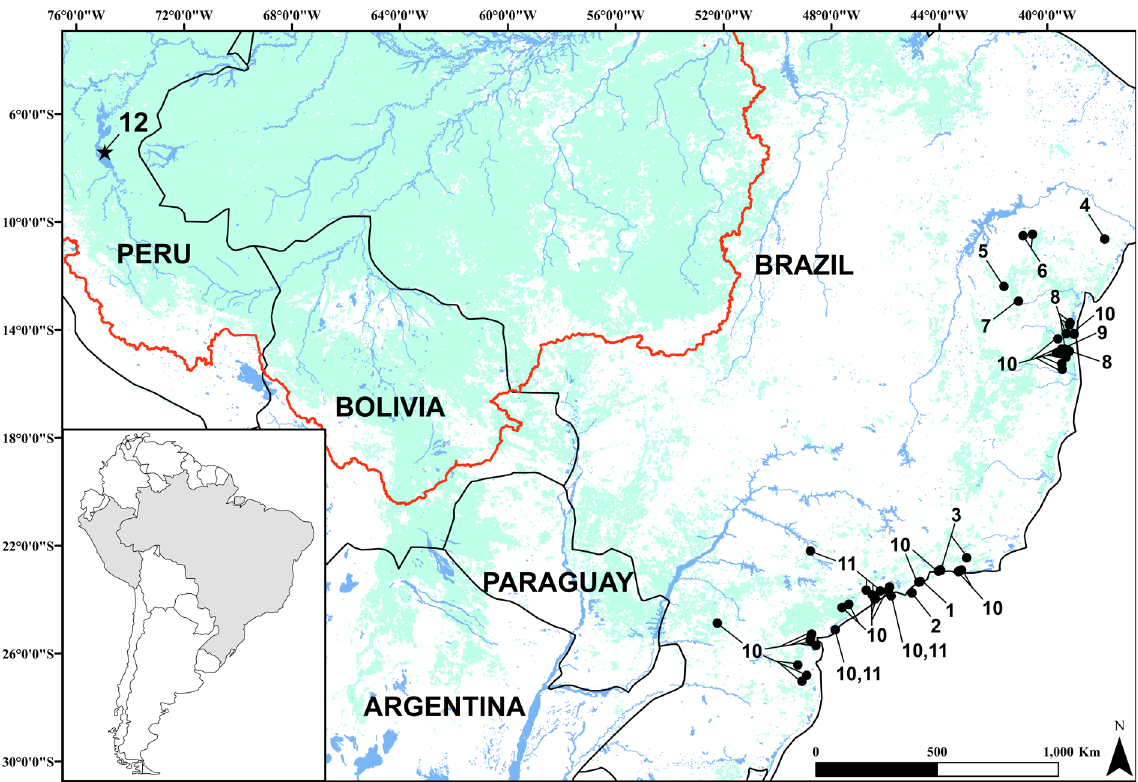
Fig. 4. Map of distribution of species of Pudeoniscidae: 1 . Brasiloniscus littoralis Cardoso, Campos- Filho & Araujo, 2018. 2 . B. maculatus Lemos de Castro, 1973. 3 . B. verrucosus Lemos de Castro,